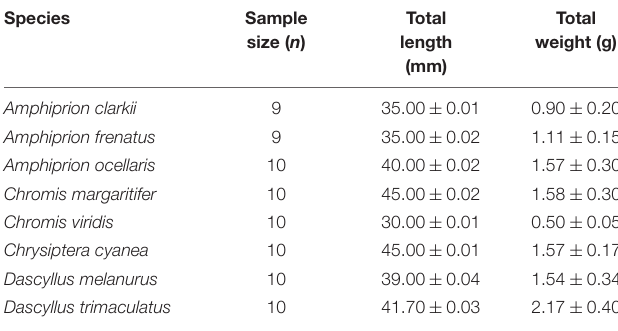
TABLE 1 | Sample size, total length and weight of fish used in experiment